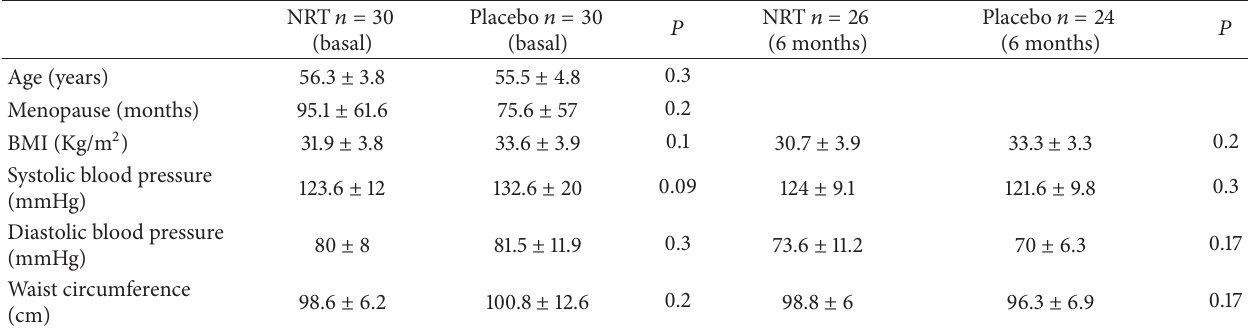
Table 1: Demographic and clinical characteristics of the study groups (mean ± SD).